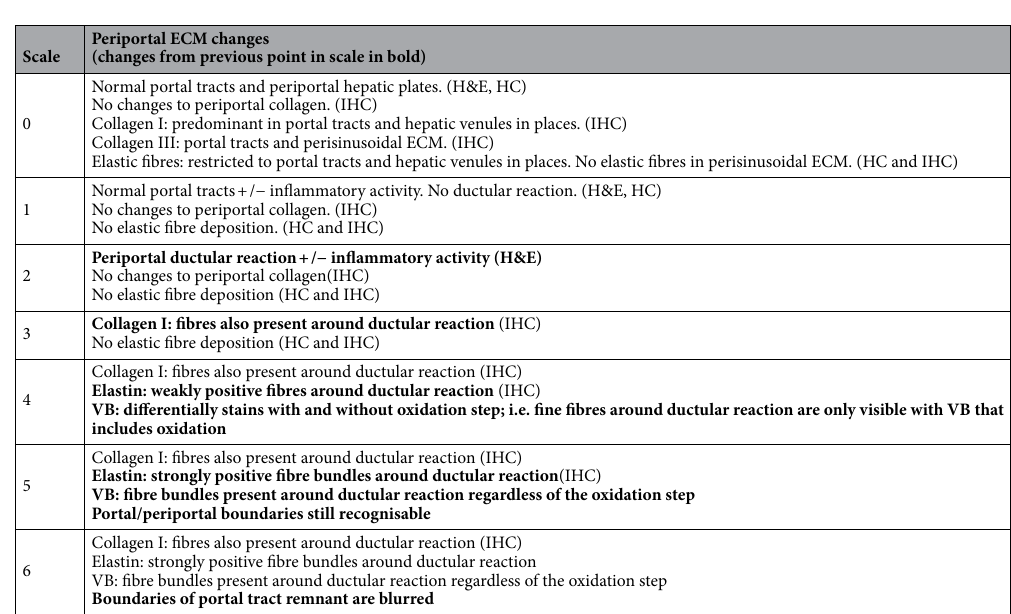
Table 2. Peri-portal stromal changes. Please note that the difference between 0 and 1 on the scale is the presence of hepatocyte injury usually in the form of zonal or sometimes panlobular/multilobular hepatocyte loss. H&E: Haematoxylin and eosin. HC: Histochemical stains (e.g. reticulin, orcein, Victoria blue (VB), picrosirius red (SR). IHC: immunohistochemical stains (e.g. collagen I, collagen III, elastin).